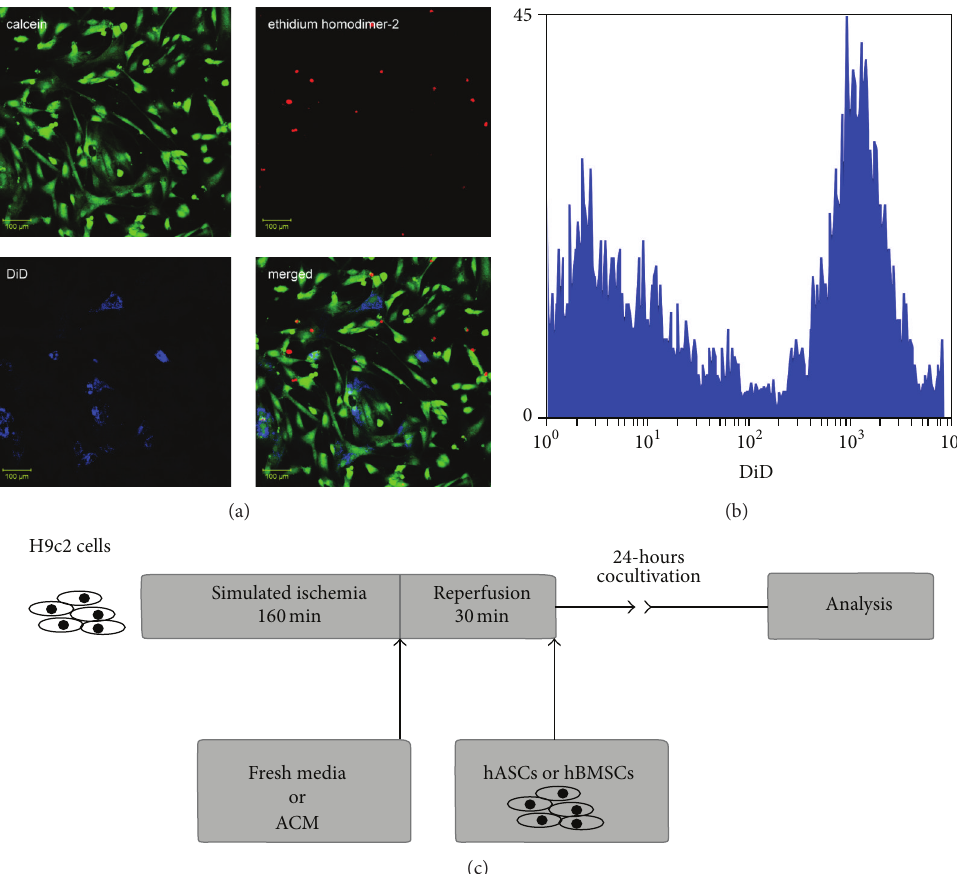
Figure 1: Ischemia-reperfusion model. (a) Representative fluorescent microscopic picture showing H9c2 cells injured with our ischemia- reperfusion model and treated with Vybrant DiD (ex/em: 644/665nm, blue) labeled cells. The cytoplasm of the living cells is stained with calcein-AM (ex/em: 494/517nm, green), the nuclei of the necrotic cells are ethidium homodimer-2 stained (ex/em: 536/624 nm, red). (b) Flow cytometric histogram on the distinction between stem cells and H9c2 cells based on DiD staining. (c) Schematic representation of the experimental